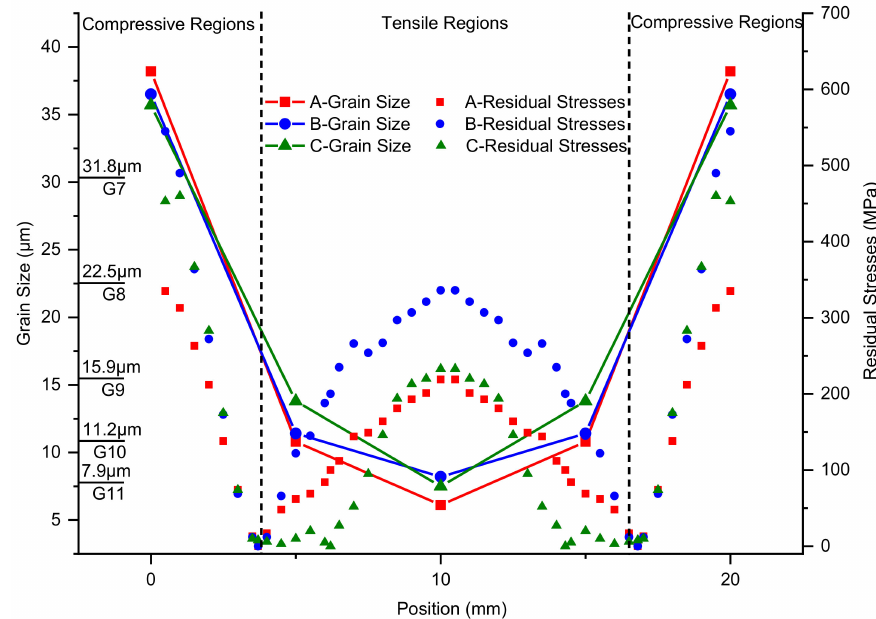
Figure 18. Mapping relationship between grain size and residual stresses.